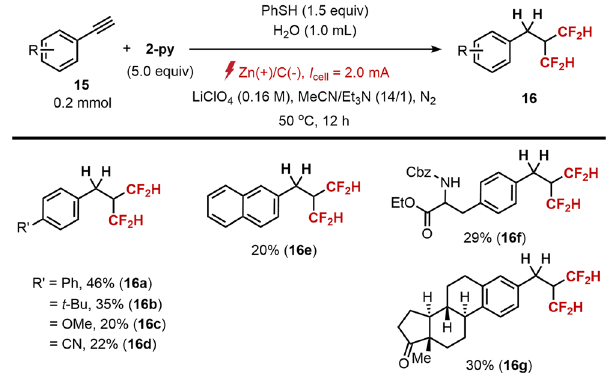
Fig. 7 Double hydrodi fl uoromethylation of alkynes a . a 15 (0.2 mmol), 2-py (0.6 mmol), LiClO 4 (0.8 mmol) and H 2 O (1.0 mL) in MeCN/Et 3 N (14/1, 4.0 mL) at 50 °C. Isolated yields are reported unless otherwise